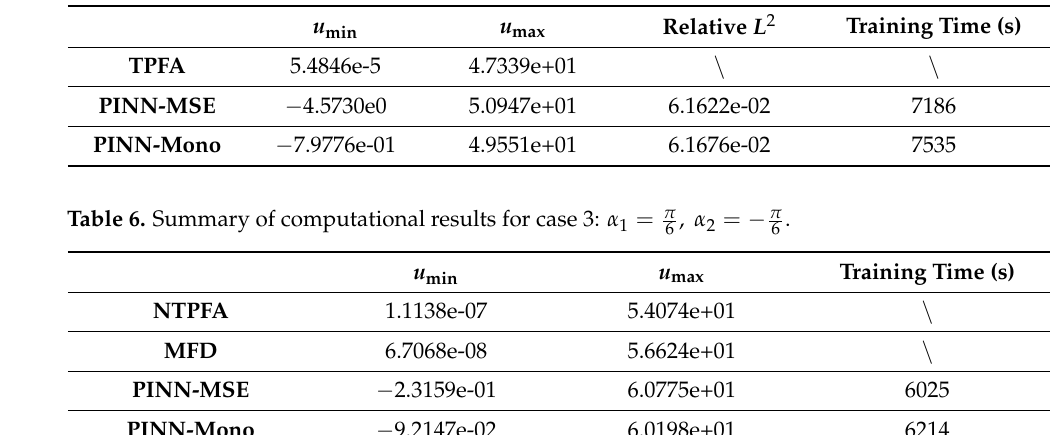
Table 5. Summary of computational results for case 3: α 1 = 0, α 2 = π